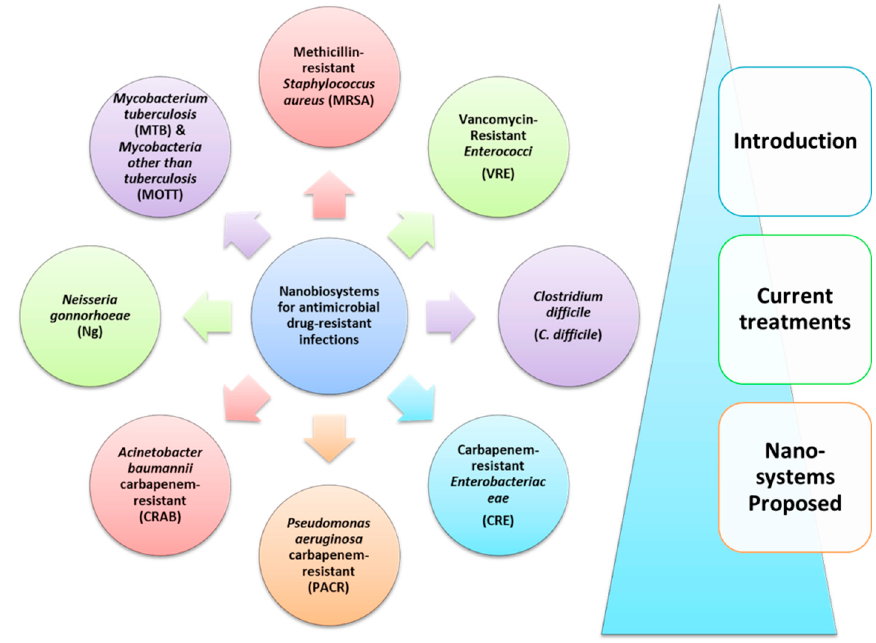
Figure 3. Pathogens investigated for proposed nanosystem treatments for infections.